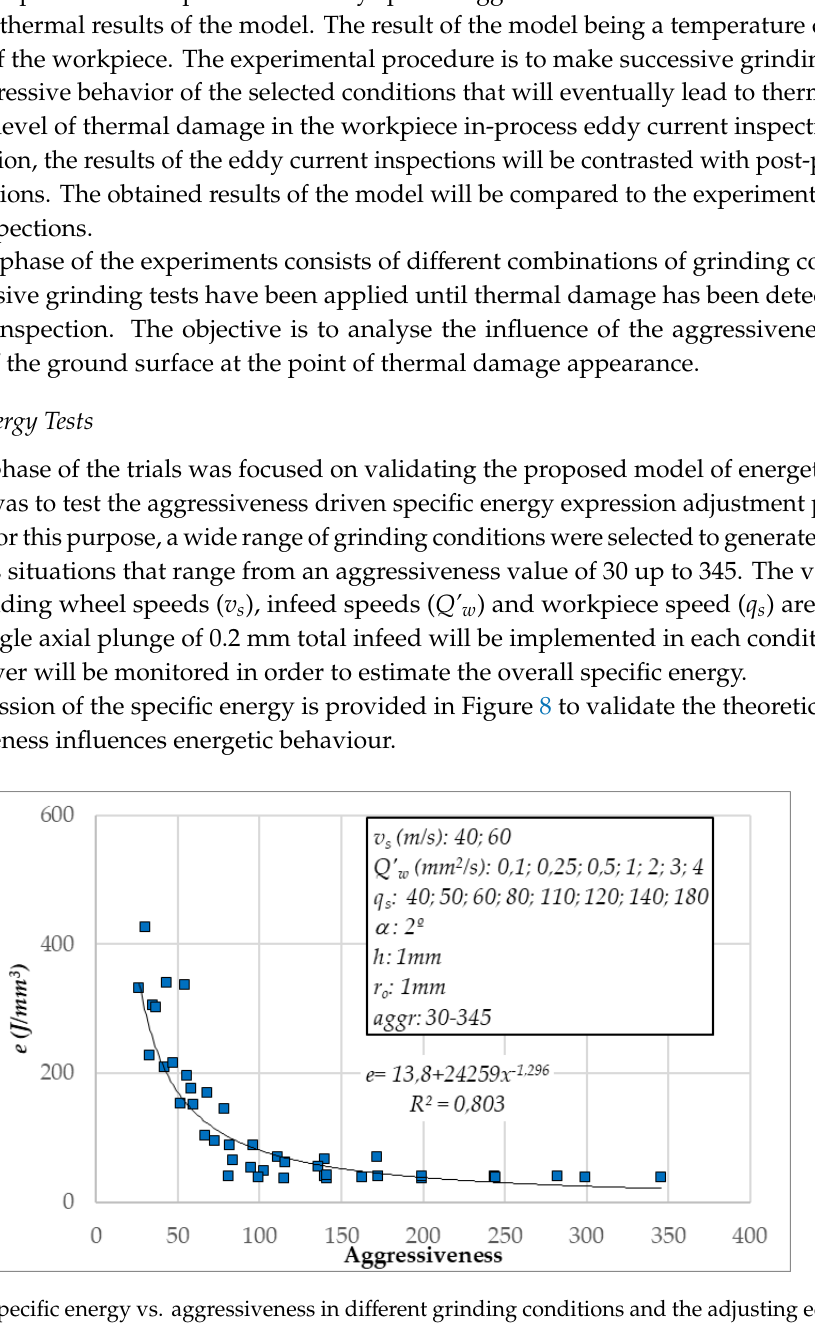
Figure 8. Specific energy vs. aggressiveness in different grinding conditions and the adjusting equation to Equation (9) .